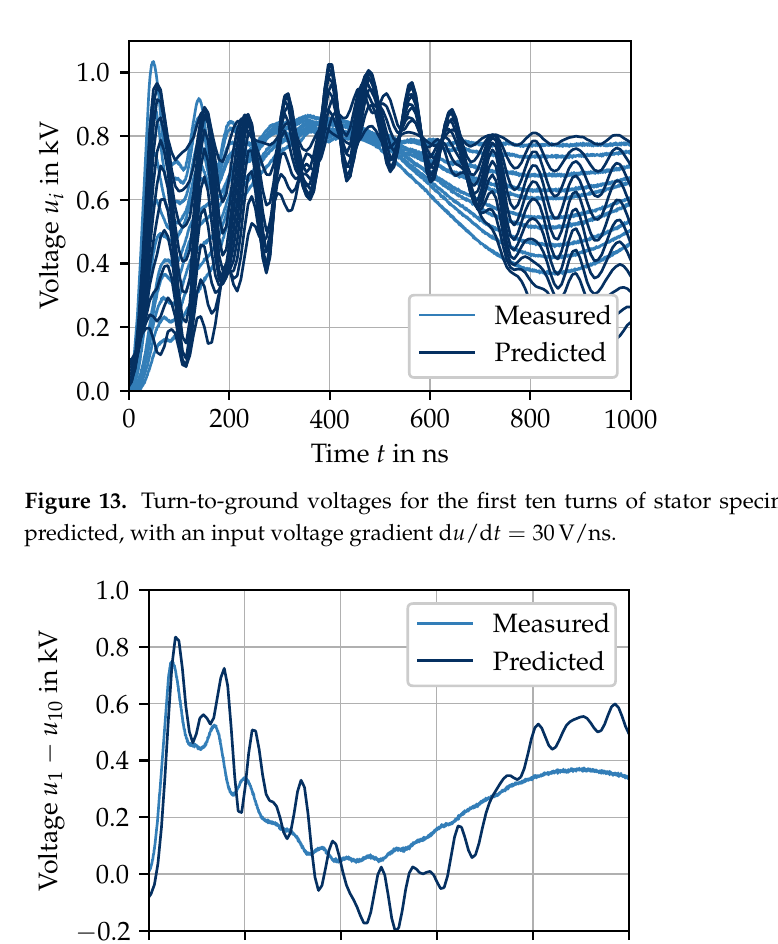
Figure 12. Single-turn model with frequency-dependent turn resistance R , self-inductance L , mutual inductance M , frequency-independent capacitance C and the additional loss elements R fe for iron losses and R ε for dielectric losses